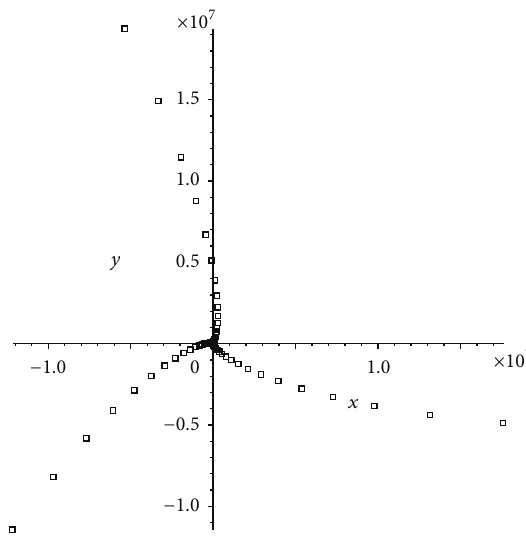
Figure 2: The solution of the Caputo-type fractional-order differ- ence initial value problem for linear system (21) with the initial condition 𝑥(0) = 0.2 , 𝑦(0) = 0.2 , where the matrix 𝐴 is given in Example 40 and 𝛼 = 0.5 , ℎ = 0.5 . In this case the roots of (53) are outside the unit